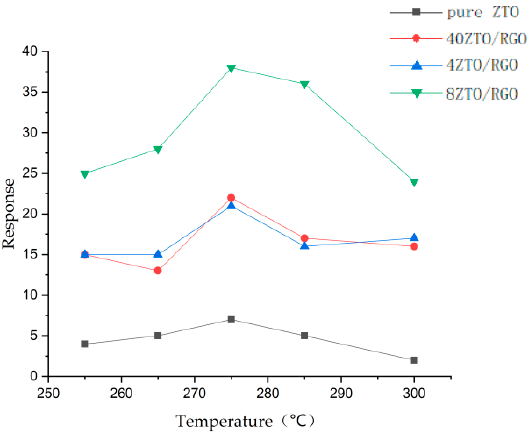
Figure 9. Graphene nanosheets can be transformed to ( a ) fullerene, ( b ) carbon nanotube, and ( c ) graphite [84].